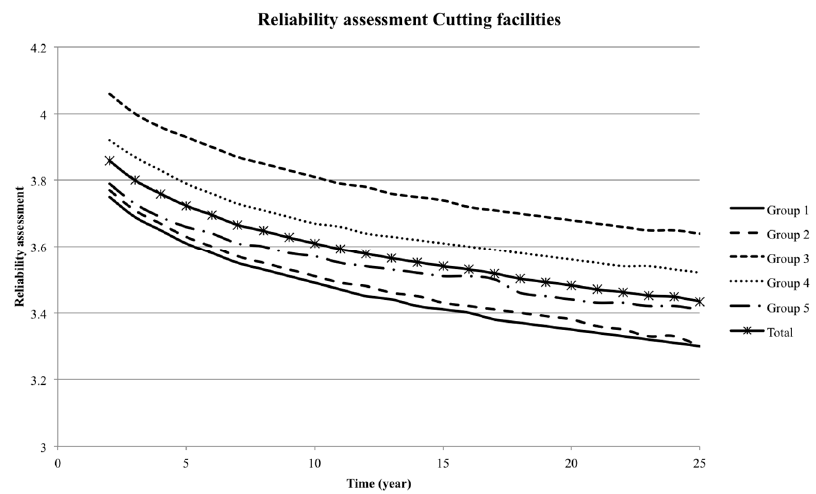
Figure 5. Annual reliability index for different groups based on test laboratories categories (sand casting).